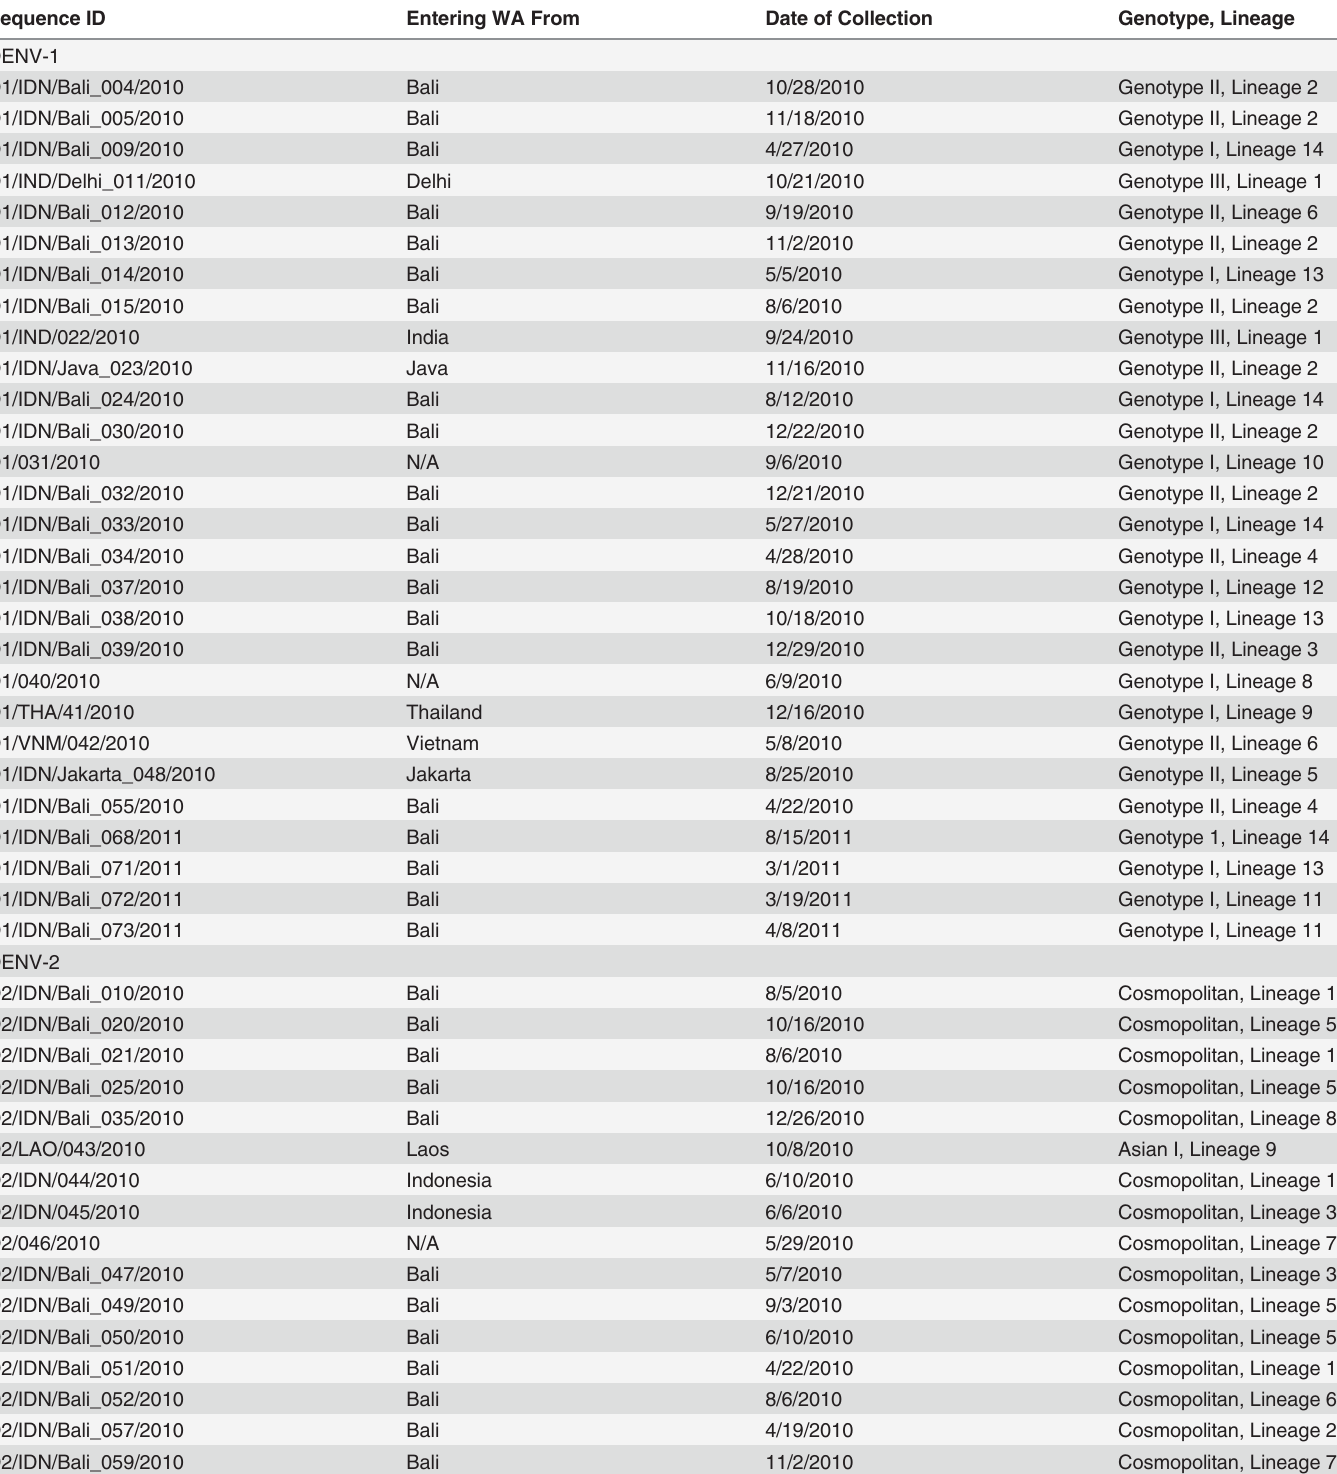
Table 1. Origin and phylogenetic placement of DENV sequences from travelers entering Western